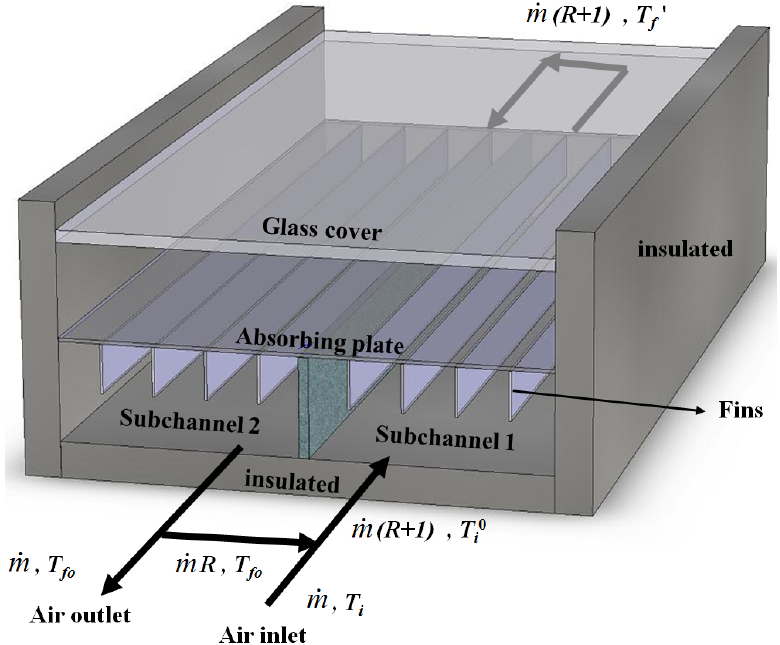
Figure 1. Schematic diagram of a downward-type double-pass external-recycle solar air heater with fins